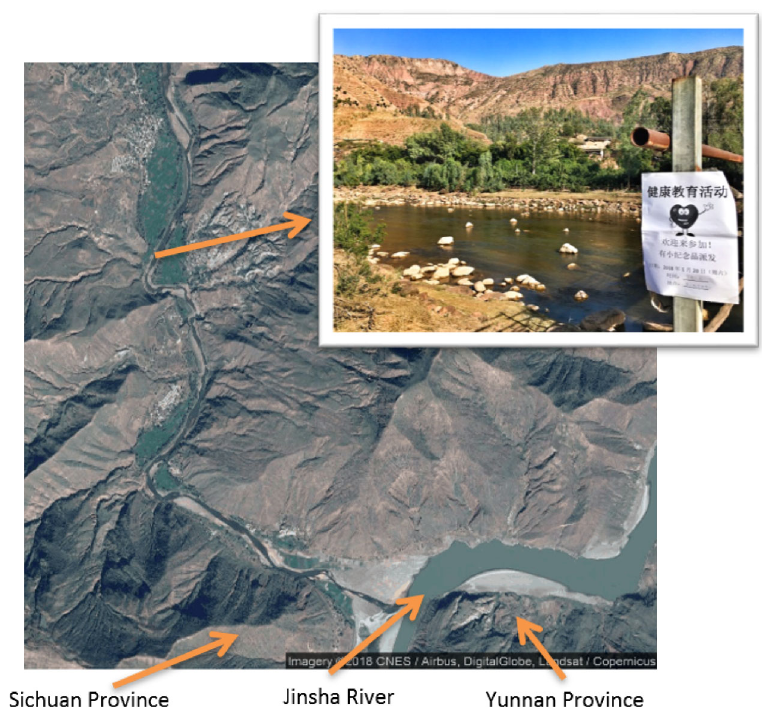
Fig. 1 Topography of the study region (generated using the ggmap package in R; Kahle and Wickham 2013) based on Google Map data (Google 2014). Photograph by Emily Y.Y. Chan, January